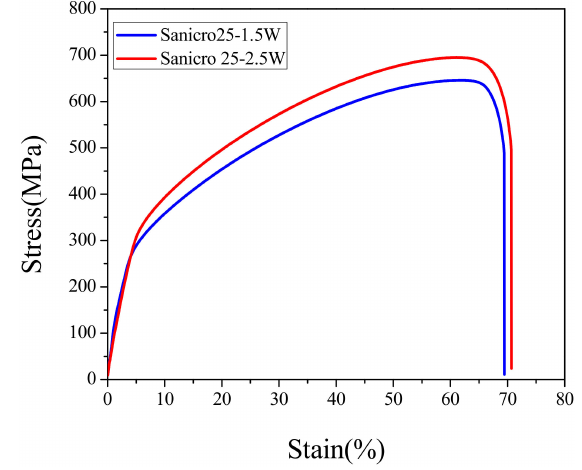
Figure 13. Stress-strain curves for two steels for room-temperature